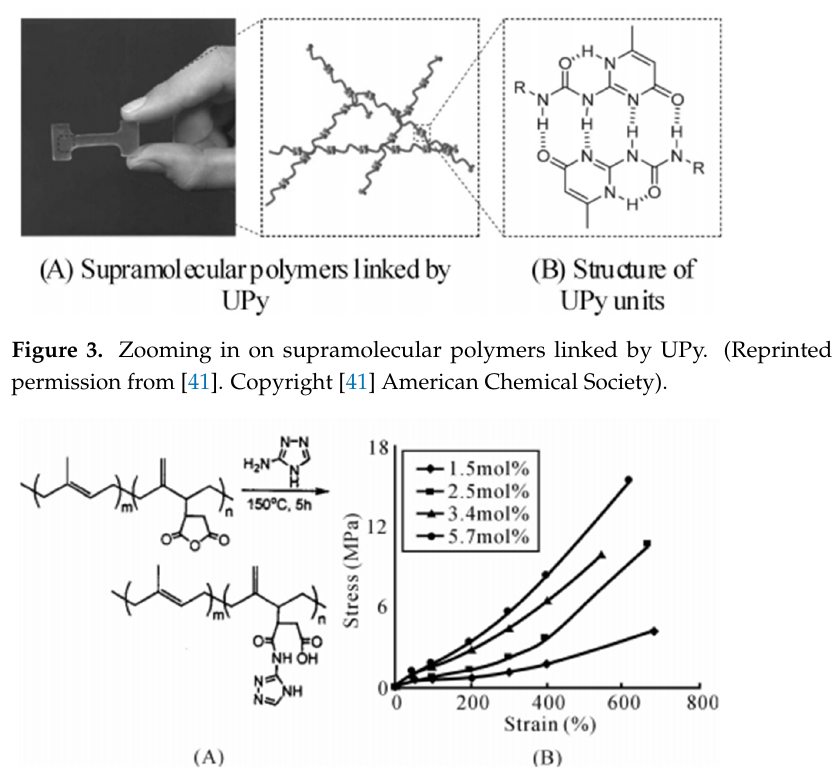
Figure 4. ( A ) Synthesis of IR-ATA and ( B ) stress-strain curves of IR-ATA with various graft ratios ATA. (Reprinted (adapted) with permission from [42]. Copyright [42] American Chemical Society.). of ATA. (Reprinted (adapted) with permission from [42] . Copyright [42] American Chemical Soci- ety.).